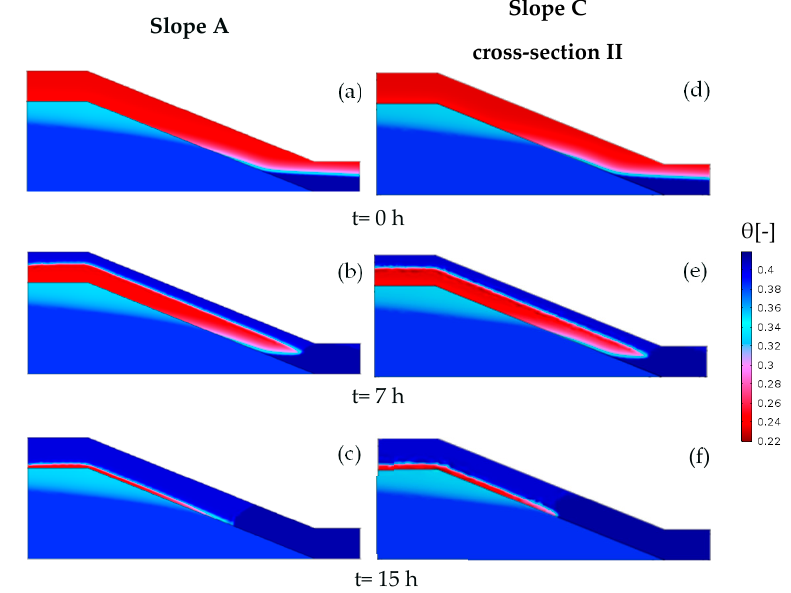
Figure 15. The temporal development of soil water content for a 15-h rainfall event with an intensity of 20 mm per hour for the 2D slope with a constant soil depth (slope A) at ( a ) t = 0 h, ( b ) t = 7 h, and ( c ) t = 15 h and a cross-section II of slope C, at ( d ) t = 0 h, ( e ) t = 7 h, and ( f ) t = 15 h.